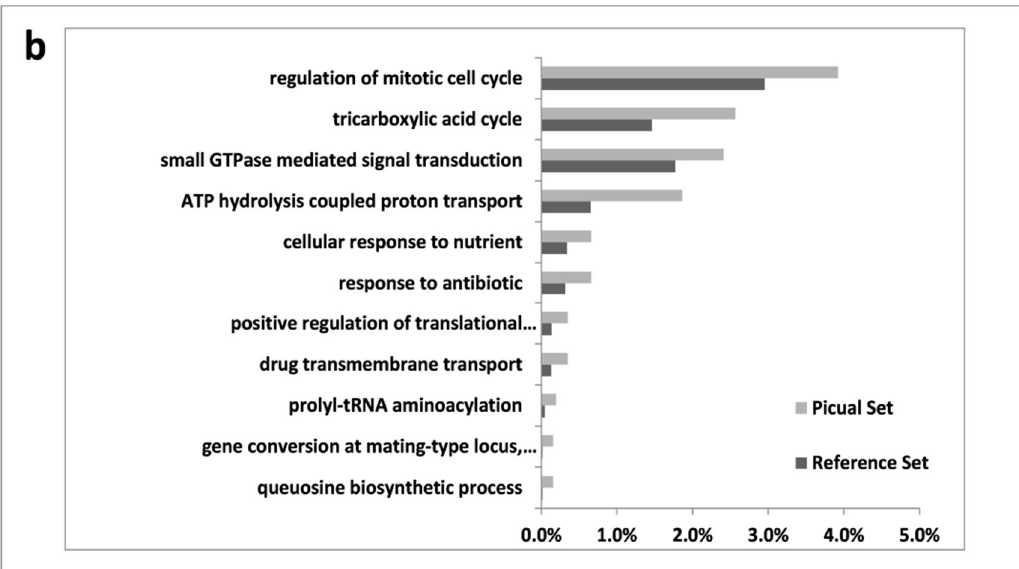
Figure 5. Group 7 unigenes that present a continuous increase of the mRNA level from 2 to 15 days post-inoculation. Unigenes were selected using an eightfold change and a 95% of False Discovery Rate; mRNA level in ‘Picual’ roots ( a ) and most specific enriched GO terms of over-expressed genes in Verticillium dahliae infecting ‘Picual’ roots ( b ).